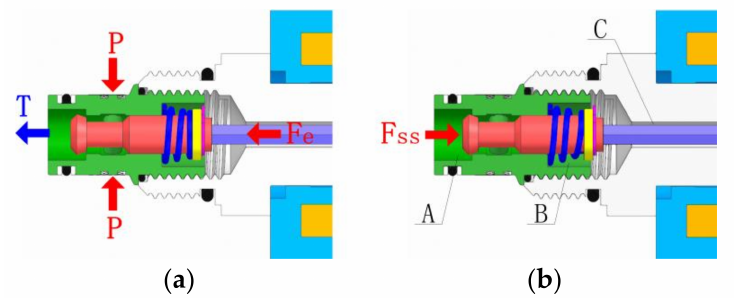
Figure 2. Valve operation states: ( a ) on-state; ( b )